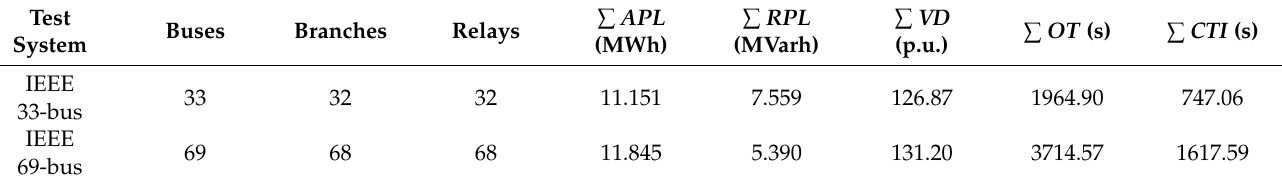
Table 1. The main parameters and characteristics of the EDN test